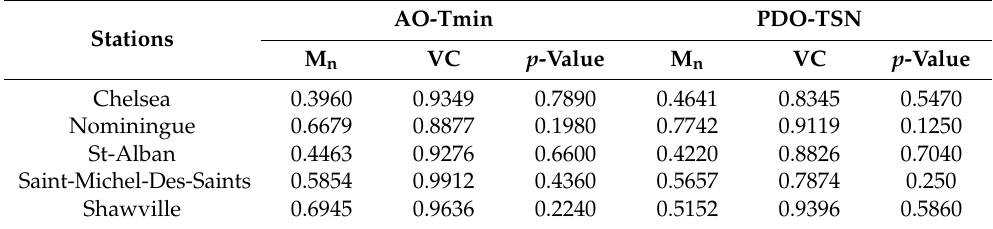
Table 8. Results of the copula method used to analyze changes in dependence between climate variables and winter climate indices (DJFM) (1950–2000) in the southwest region.